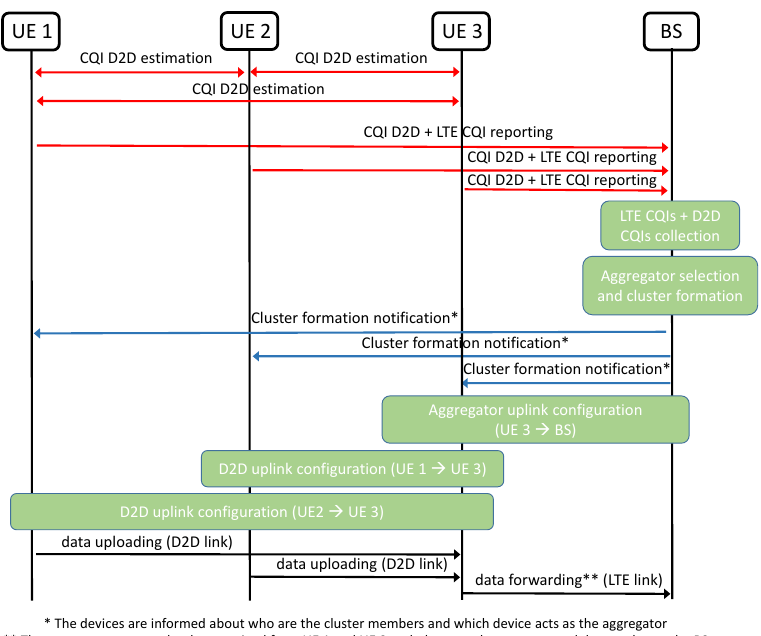
Figure 3. Message diagram for the proposed D2D cluster-based IoT data